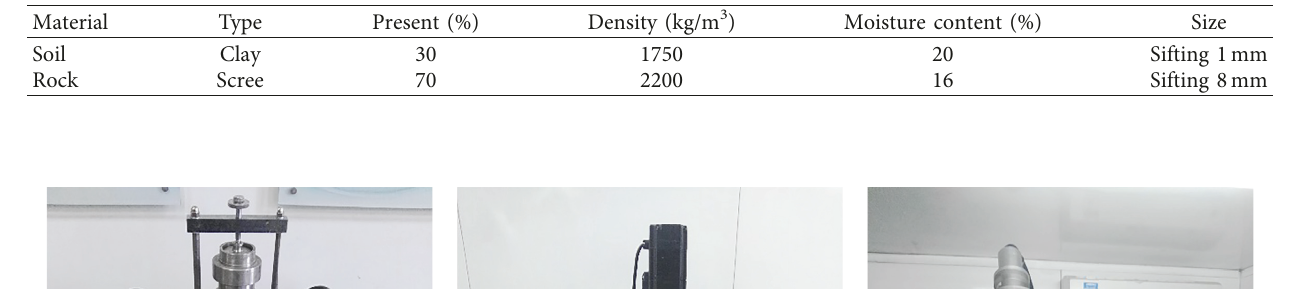
Table 1: Soil-rock mixture